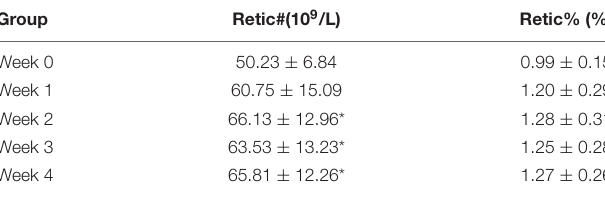
TABLE 2 | The Retic# and Retic% of subjects during IHE intervention. Group Retic#(10 9 /L) Retic% (%) Week 0 50.23 ± 6.84 0.99 ± 0.15 Week 1 Week 3 1.25 ± 0.28 Week 4 65.81 ± 12.26* 1.27 ±